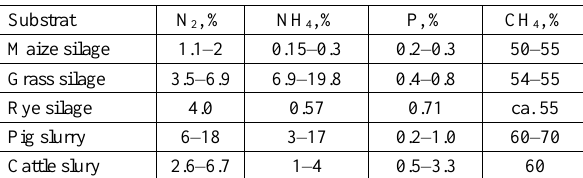
Table 3. Substrates for the production of agricultural biogas and their composition [16] Substrat N 2 , % NH 4 , % P, % CH 4 , % Maize silage Grass silage Rye silage Pig